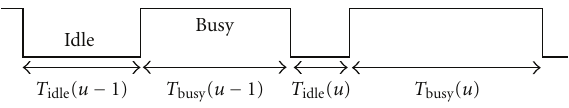
Figure 1: The conceptual diagram of idle and busy durations.